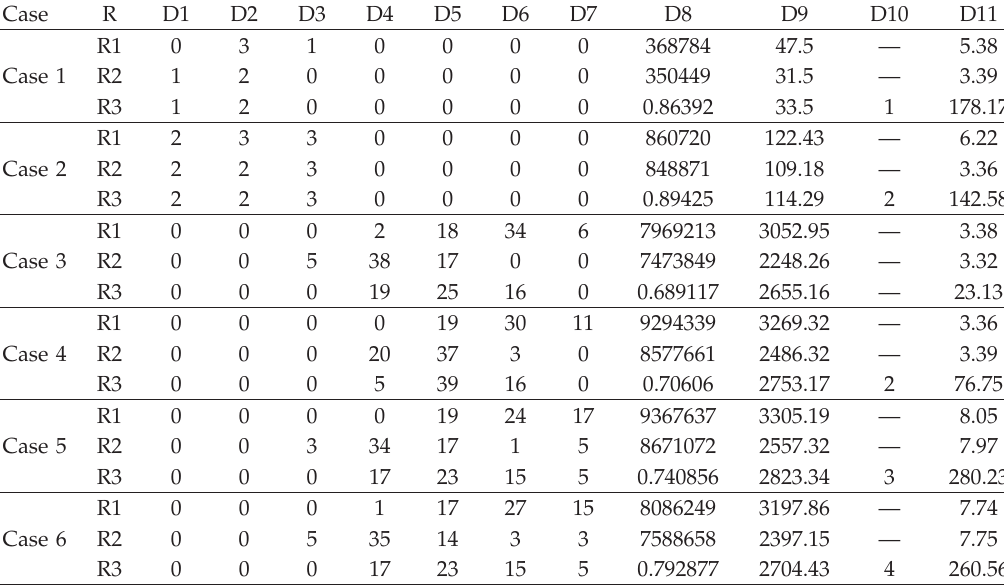
Table 1: Rescheduling results of di ff erent cases.